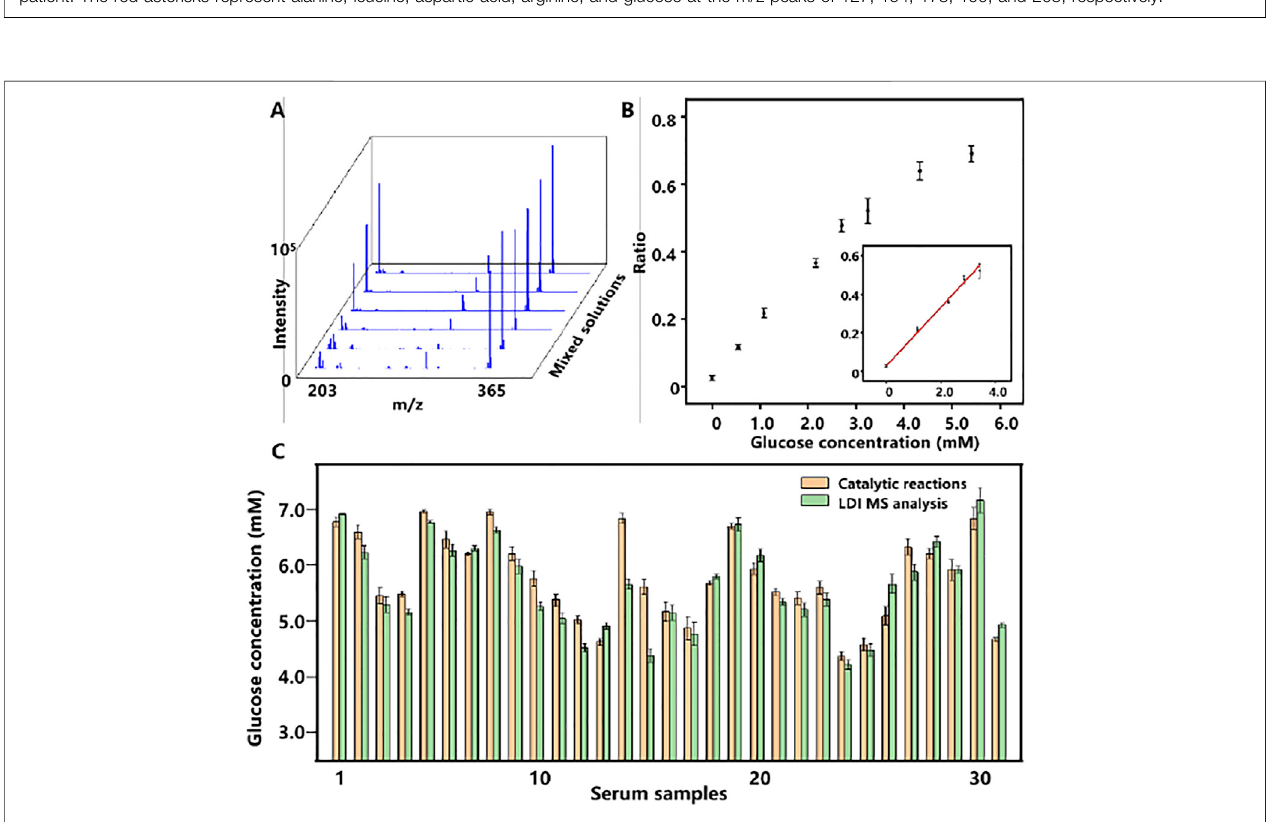
FIGURE 4 | (A) LDI MS spectra of a gradient concentration of glucose and cellobiose (IS). (B) The relationship plot and the linear curve (inset) of the relative peak intensity of glucose ( I 203 /I 365 ) and the concentrations of glucose. The error bars denote the SD of three measurements. (C) Dual-mode glucose detection results of 31 serum samples. The error bars denote the SD of fi ve